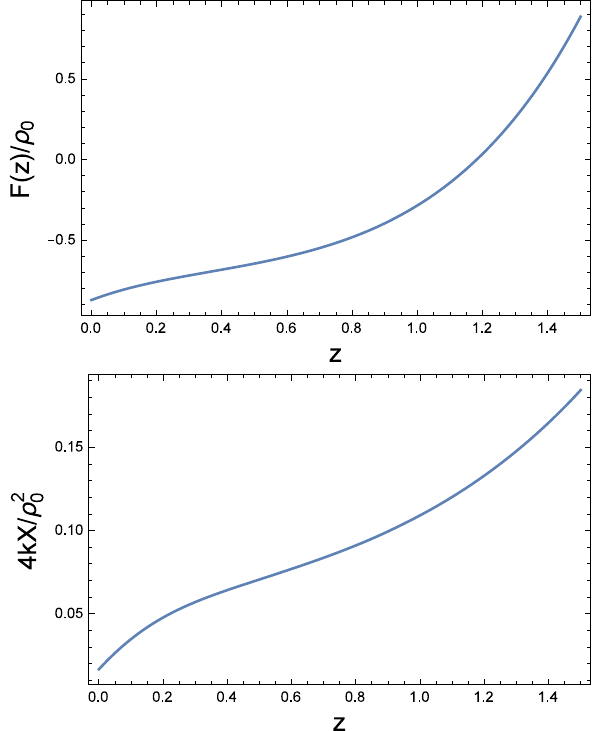
Fig. 5 Here we display F and X as a function of redshift based on Eqs. (33) and (34) for model C